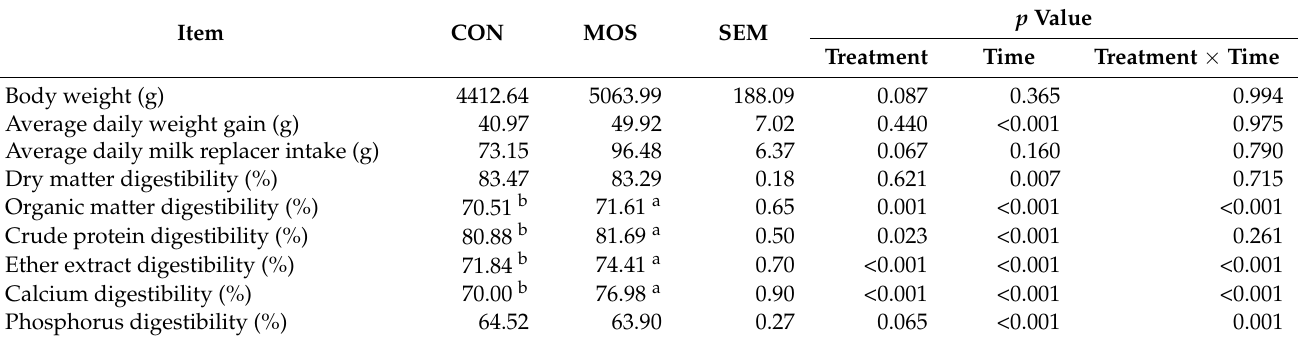
Table 2. Growth performance and nutrient digestibility of Hu lambs treated with either control or mannan oligosaccharides.